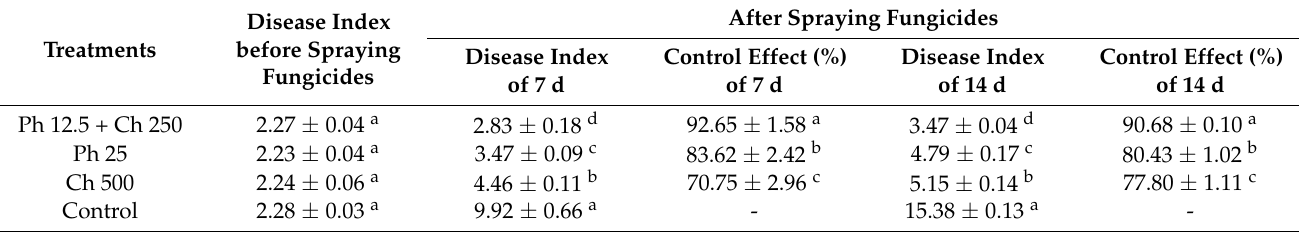
Table 2. The efficacy of physcion + chitosan, physcion, and chitosan control powdery